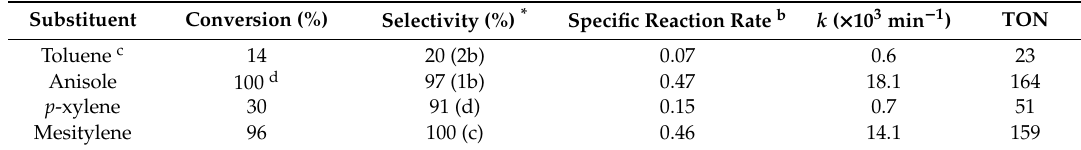
Table 2. Catalytic reactivity of Huntly-GP in the acylation of several aromatics with BzCl as the acylating agent a .